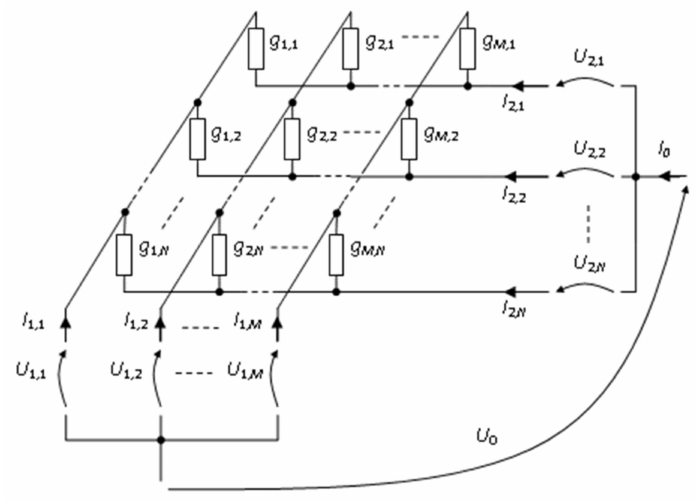
Figure 4. Circuit diagram of the MMC topology with signals from external